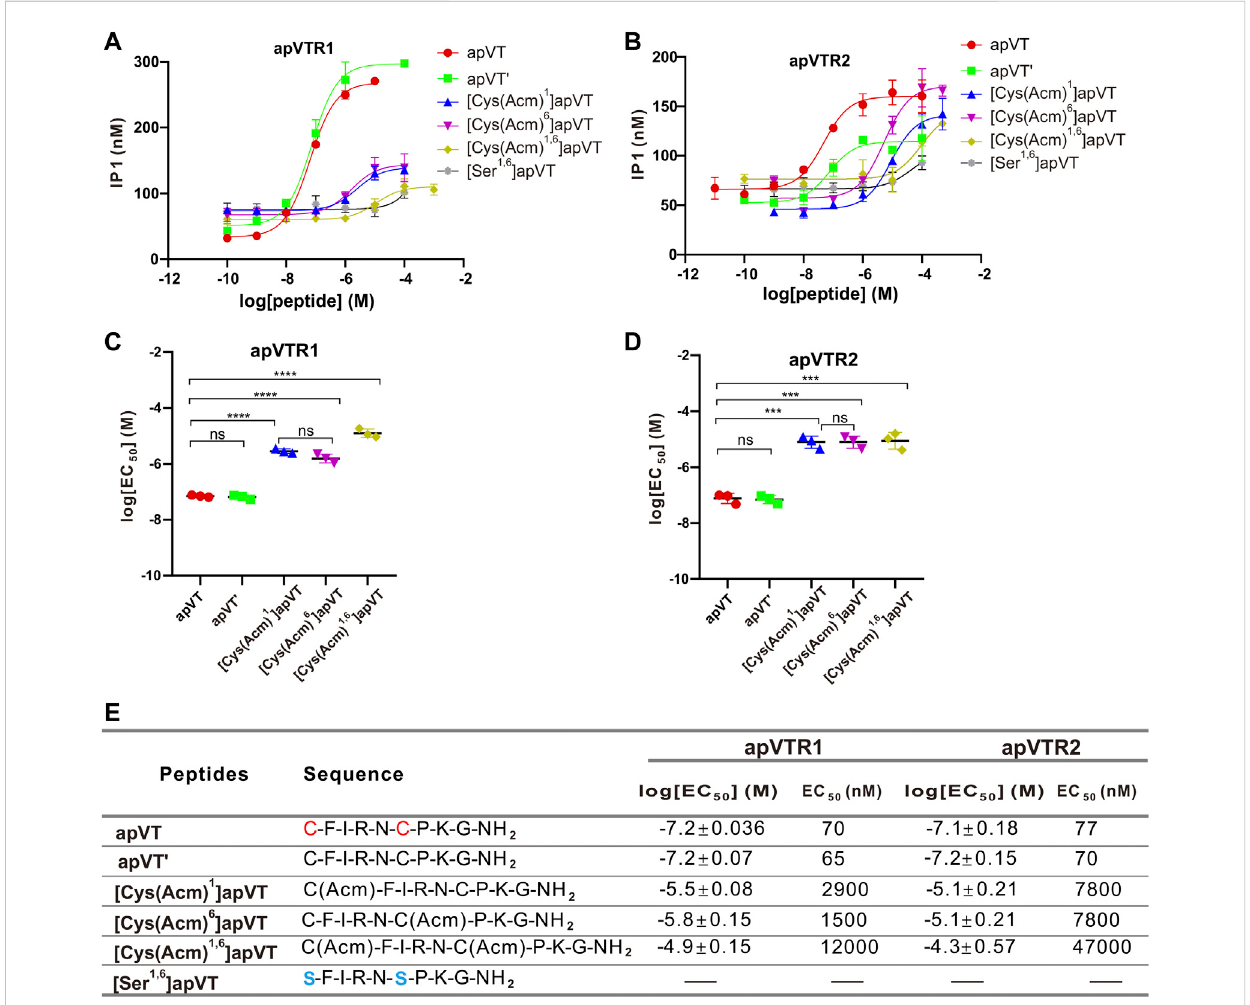
FIGURE 7 Activation of apVTRs by apVT analogs without the disul fi de bond. (A) Activation of apVTR1 by apVT analogs without the disul fi de bond: apVT ’ , [Cys (Acm) 1 ]apVT, [Cys (Acm) 6 ]apVT, [Cys (Acm) 1,6 ]apVT and [Ser 1,6 ]apVT; apVT was used as a control. (B) Activation of apVTR2 by apVT analogs without the disul fi debond:apVT ’ ,[Cys(Acm) 1 ]apVT,[Cys(Acm) 6 ]apVT,[Cys(Acm) 1,6 ]apVTand[Ser 1,6 ]apVT;apVTwasusedascontrol. (C) Comparisonoflog[EC 50 ]for apVTR1activationbyapVTandthe fi veapVTanalogs( n =3foreach)shownin (A) .One-wayANOVA,F(4,10)=249.4, p < 0.0001. (D) Comparisonof log[EC 50 ]forapVTR2activationbyapVTandthe fi veapVTanalogs( n =3foreach)shownin (B) .One-wayANOVA,F(4,10)=80.41, p < 0.0001.Bonferroni posthoc test:ns,notsigni fi cant;***, p < 0.001;****, p < 0.0001. (E) SequencesofapVTandallapVTanalogstestedandsummaryoftheaveragelog[EC 50 ] and EC 50 on apVTR1 and